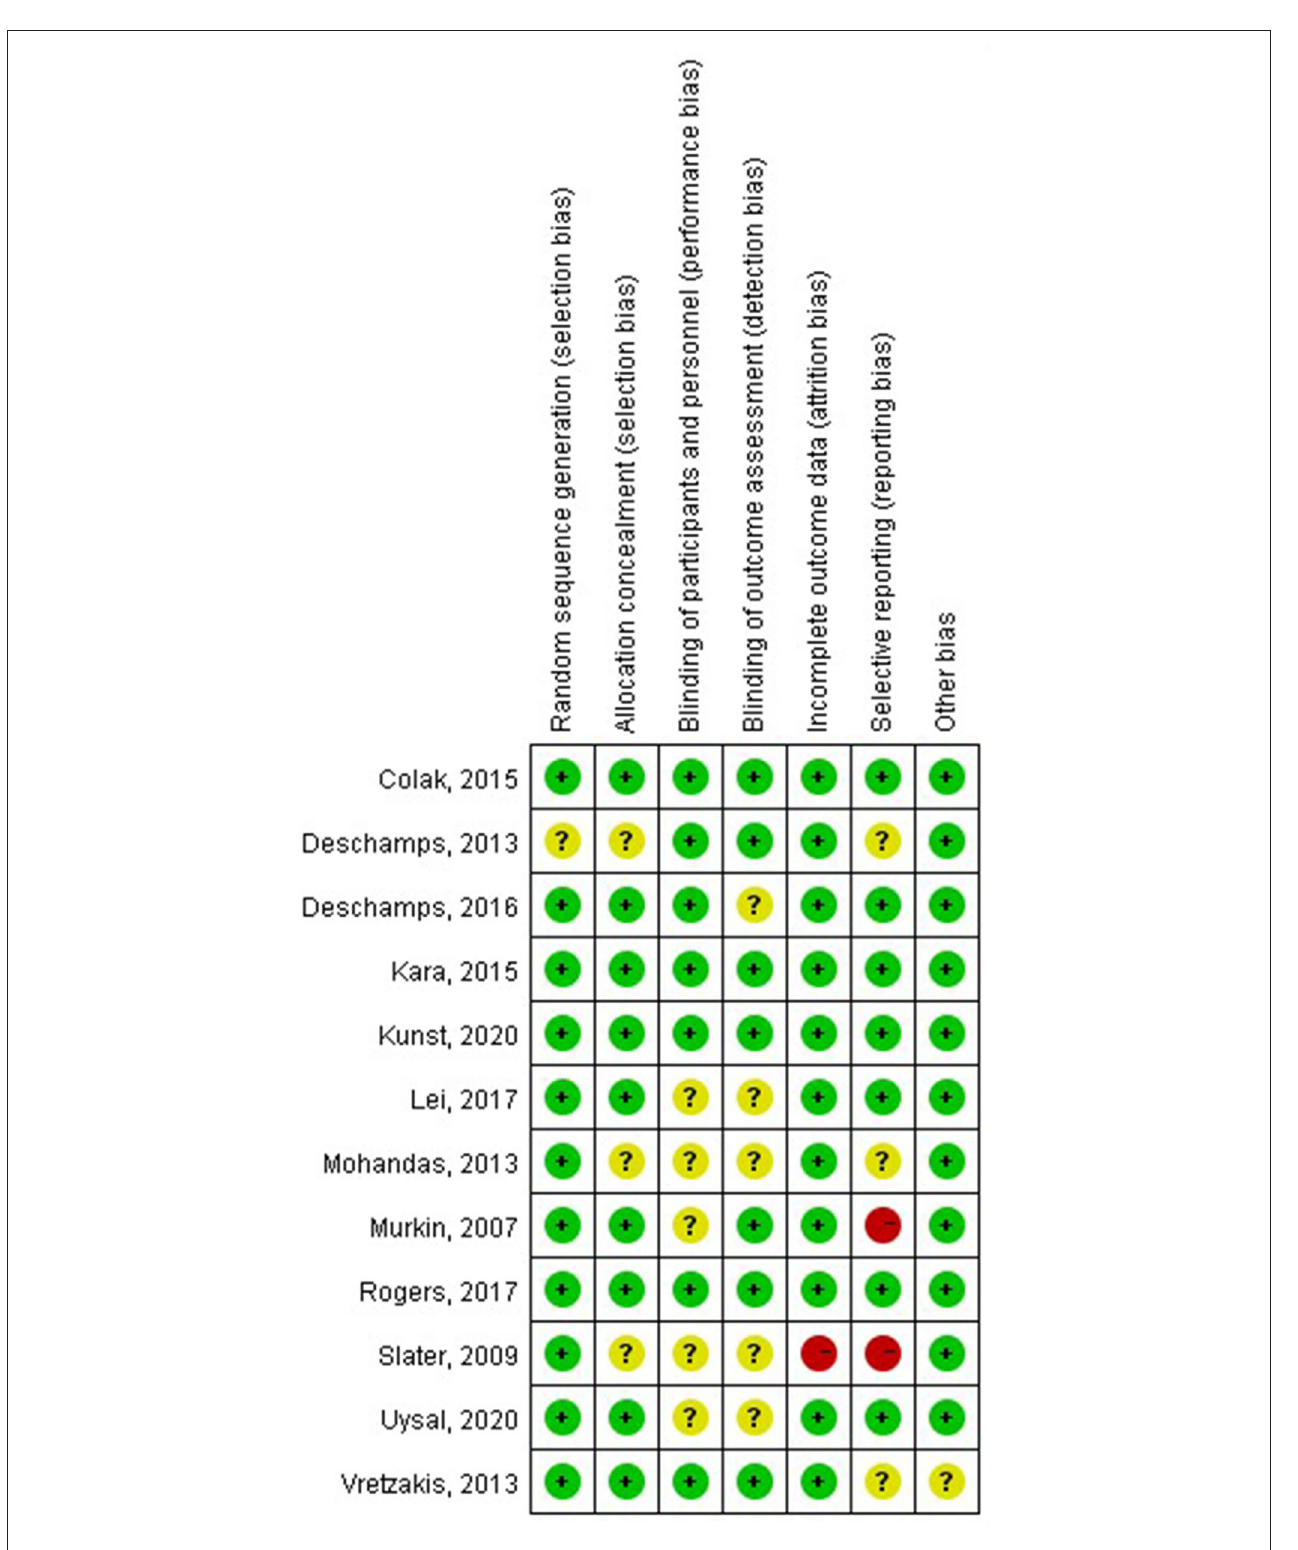
FIGURE 2 | Risk of bias summary of review authors’ judgments about each risk of bias item for each included study.